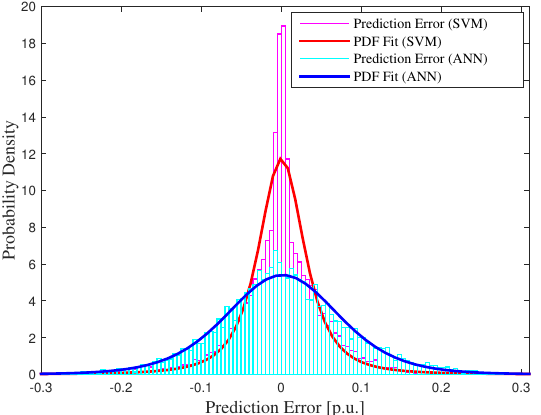
Figure 4. PDFs of the prediction errors for the ANN and SVM schemes. Table 2. Parameters of the t location-scale distribution for the ANN and SVM